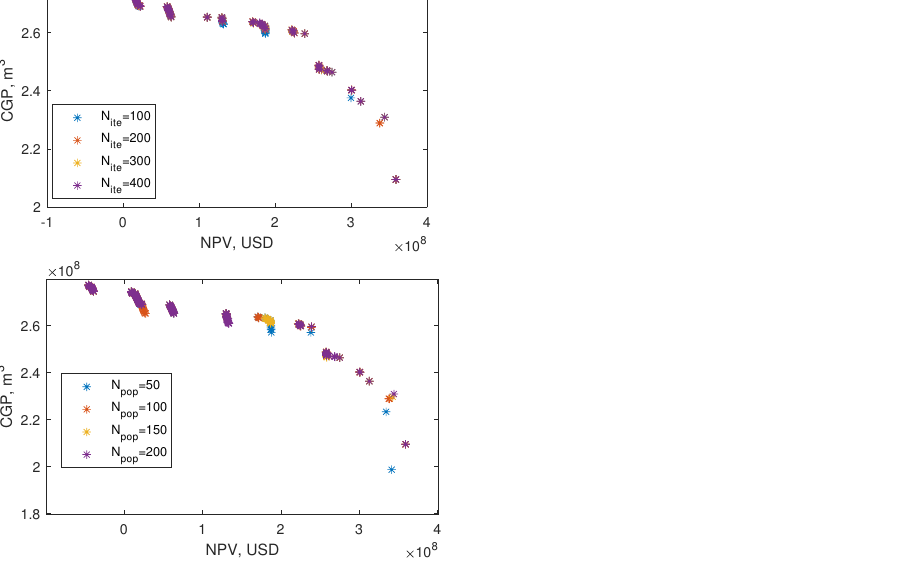
Figure 15. Illustration of the Pareto fronts solution ( NPV , CGP ) at the final generation with respect to population size and iteration steps for the NSGA-II algorithm.